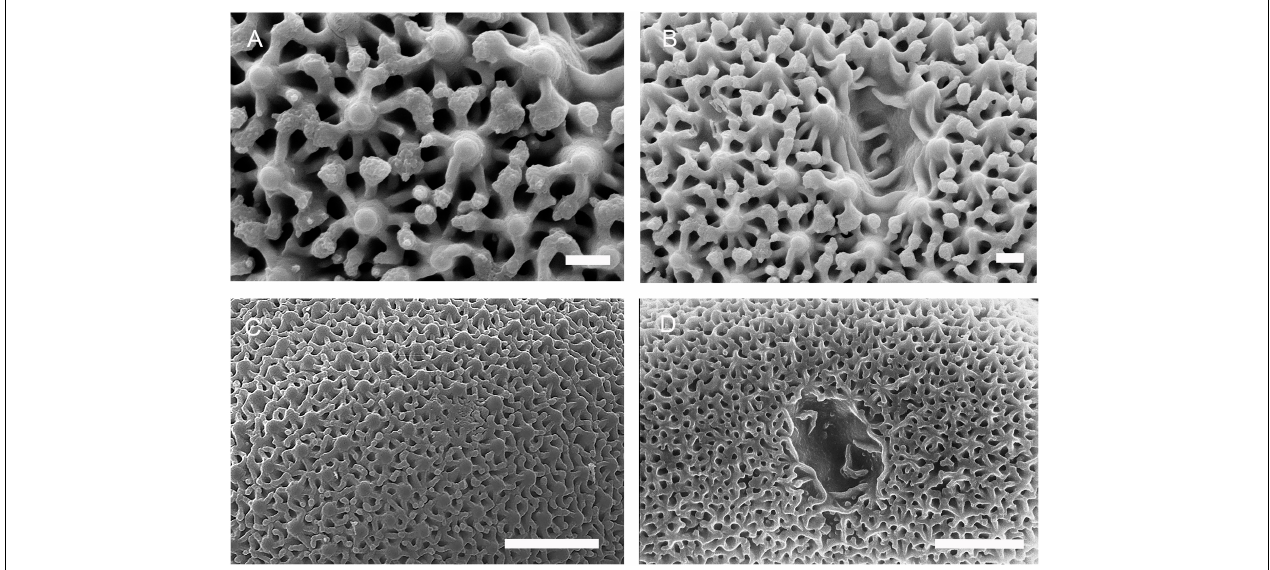
FIGURE 8 | Morphology of selenaster surfaces from Placospongia . (A,B) Surface and hilum of selenaster, Placospongia melobesioides (Florida, USNM 39643). Note the typical polygonal pattern around a central knob. Scale: 2 µ m. Picture: K. Rützler. (C) Surface of selenaster, Placospongia ruetzleri (holotype, RMNH 9872). Scale: 10 µ m. Picture: R.W.M. van Soest. (D) . Surface and hilum of selenaster, Placospongia decorticans (Ras El Chakaa, cave, Lebanon, Endoume collection). Scale: 10 µ m. Picture: S.